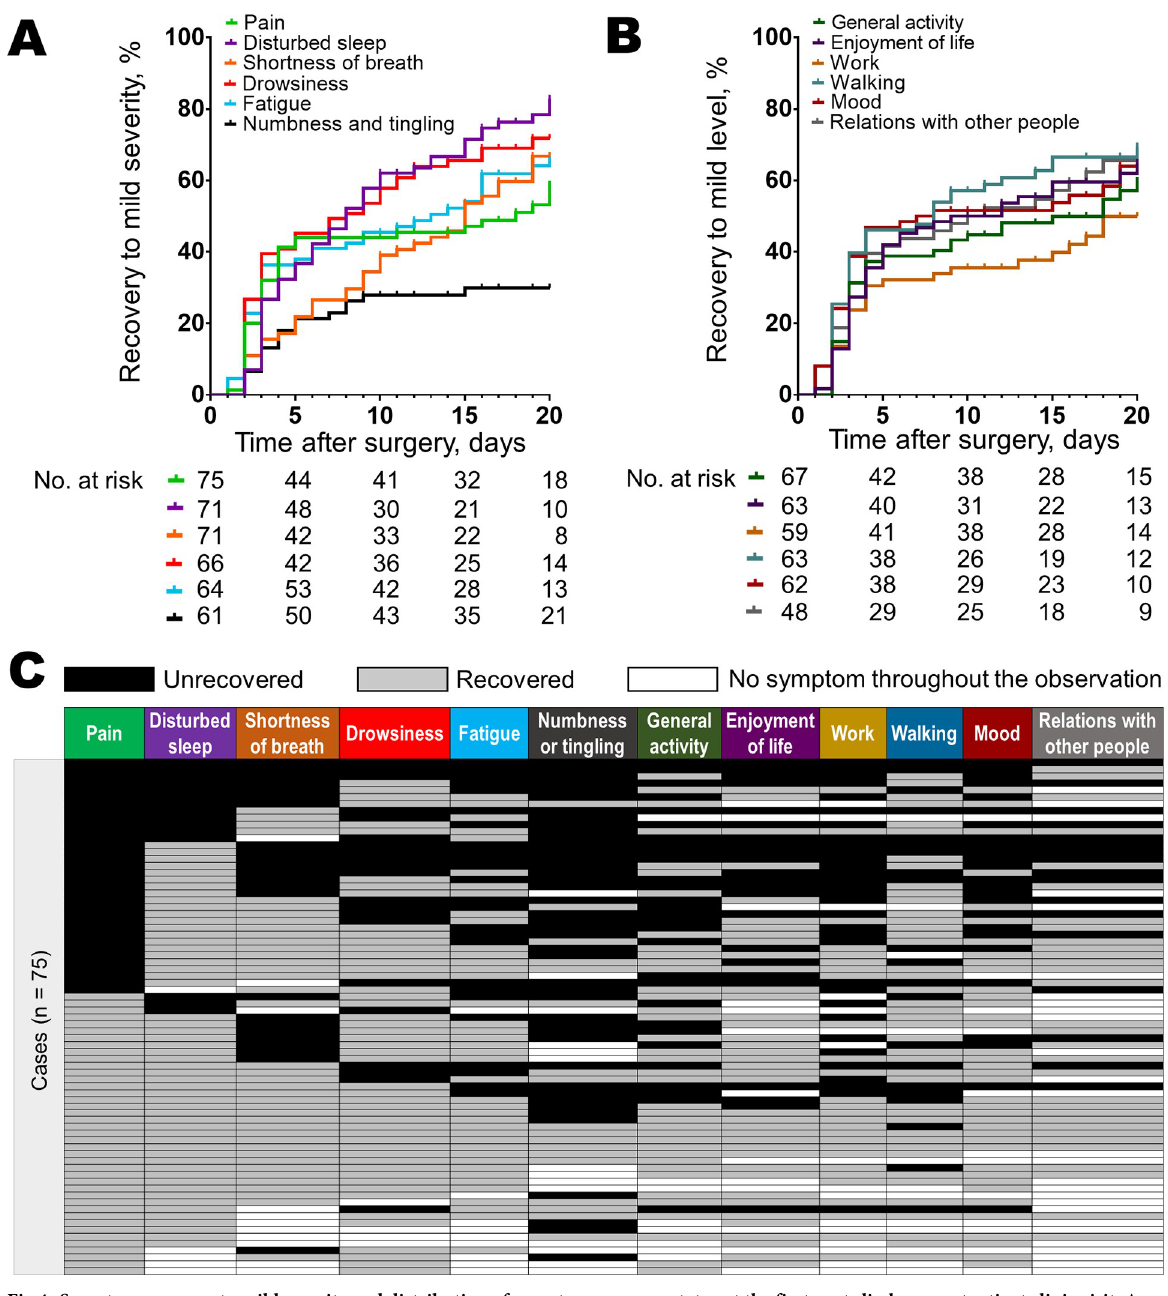
Fig 4. Symptom recovery to mild severity and distribution of symptom recovery status at the first post-discharge outpatient clinic visit. A: The cumulative rates of symptom recovery to a mild level of pain, interfered general activity, disturbed sleep, interfered enjoyment of life, and interfered work were 57.6%, 53.4%, 82.0%, 64.1%, and 50.2%, respectively. B: The cumulative rates of symptom recovery to a baseline level of pain, interfered general activity, disturbed sleep, interfered enjoyment of life, and interfered work were 16.4%, 20.4%, 39.7%, 38.3%, and 28.2%, respectively. C: The distribution of symptom recovery status at the first post-discharge follow-up visit revealed a higher mean number of unrecovered symptoms/ interferences in patients with unrecovered pain, than those with recovered pain (5.8 vs 1.9, respectively, P < 0.0001).